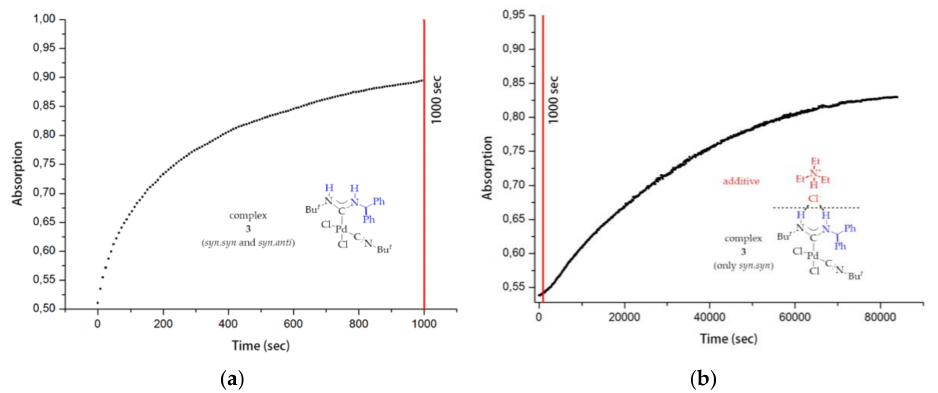
Figure 11. Kinetic curves of decomposition of: 6 in CHCl 3 solution with 10 equiv. of Et 3 N ( a ); and 6 with 10 equiv. of Et 3 N in the presence of 10 equiv. Et 3 N · HCl ( b